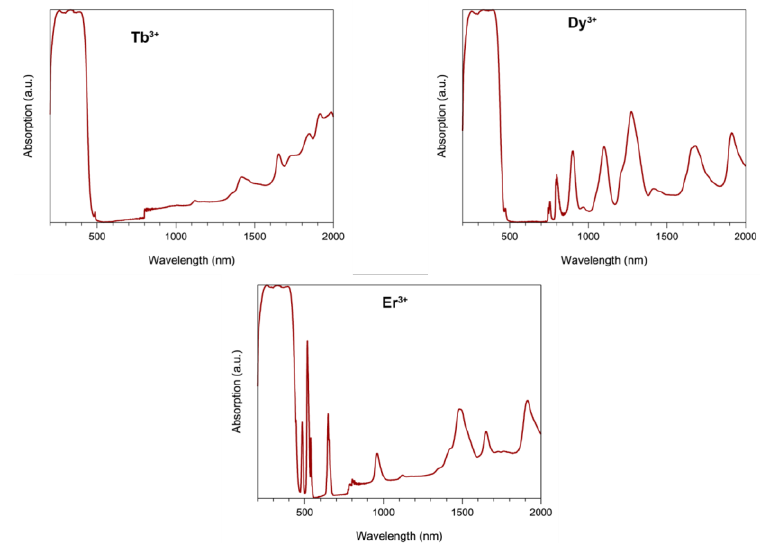
Figure 3. Solid-state (diffuse reflectance) electronic spectra of complexes 2 (top left), 3 (top right) and 4 (bottom) in the 250–2000 nm range.